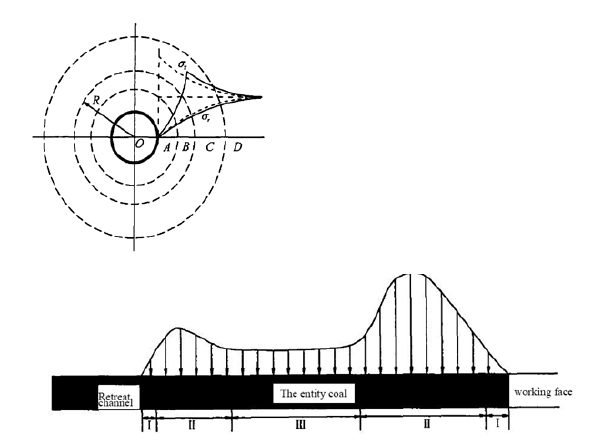
Fig. 2 (A) Stress distribution in surrounding rock. (B) Plastic